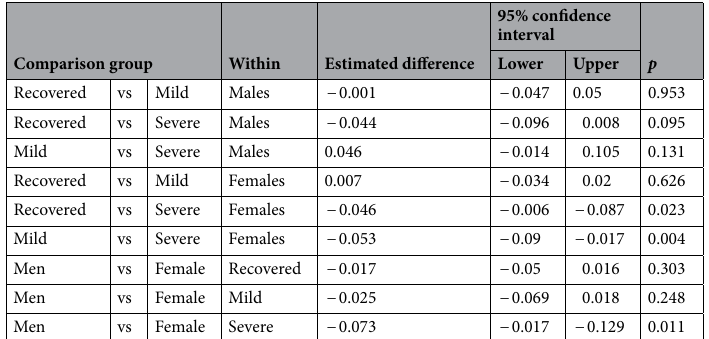
Table 6. Differences in least square mean magnetization transfer ratio homogeneity from general linear mixed model when controlling for clinical outcome and sex, including imputed data.